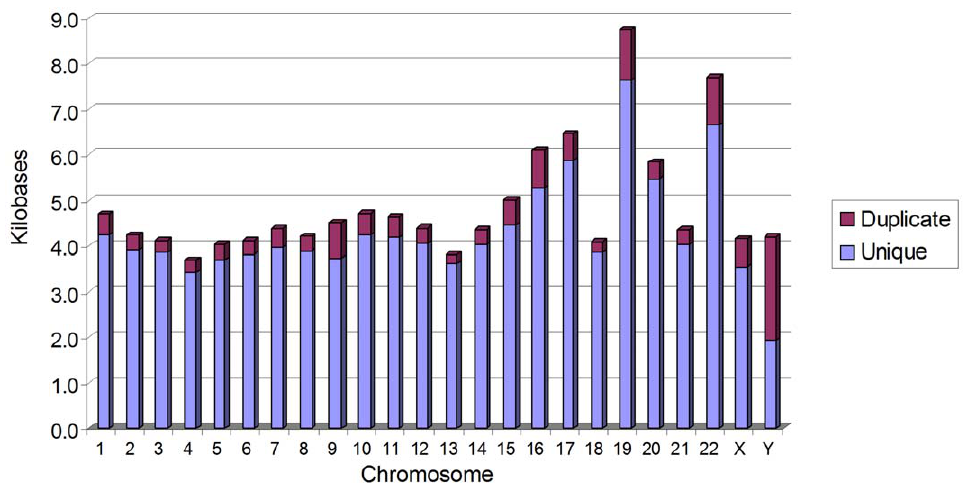
Figure 5. Average distance between FRT -like sequences in human chromosomes. The highest density of FRT -like sequences is in chromosome 4; the lowest density is in chromosome is 19. The ratio of unique to duplicated FRT -like sequences is indicated by the relative size of the bars.